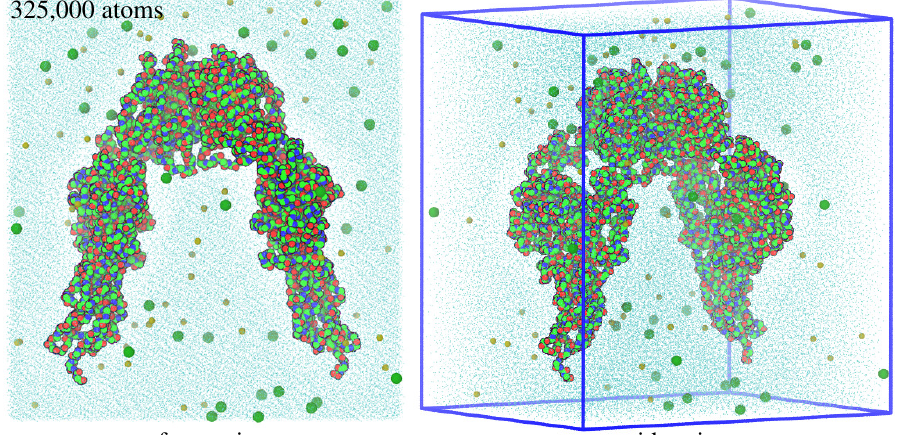
Figure 6. MD simulation domain. Front and side views of solvated and ionized IGF1R ∆ β are shown. The simulation domain measures 158 × 170 × 126 Å 3 and contains ∼ 325,000 atoms. Protein, ion and water molecules are shown in space-filling, spherical and wireframe representations,